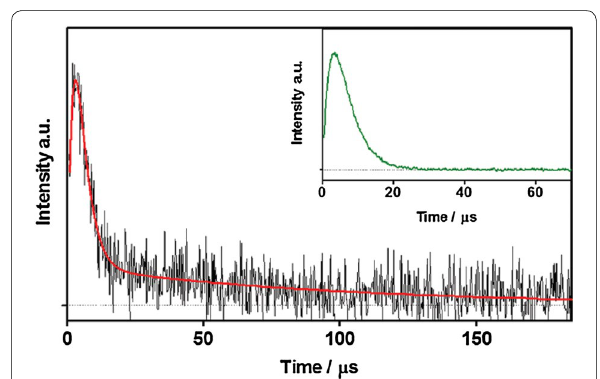
Fig. 5 Time‑resolved 1 O 2 phosphorescent signals for Pp2FbFP L30 M (λ ex 355 nm) in an air‑saturated PBS solution at λ = corresponding trace for FMN was included in the inset for compari‑ son to show the absence of the long‑lived tail (Reproduced from [67] with the permission of Royal Society of